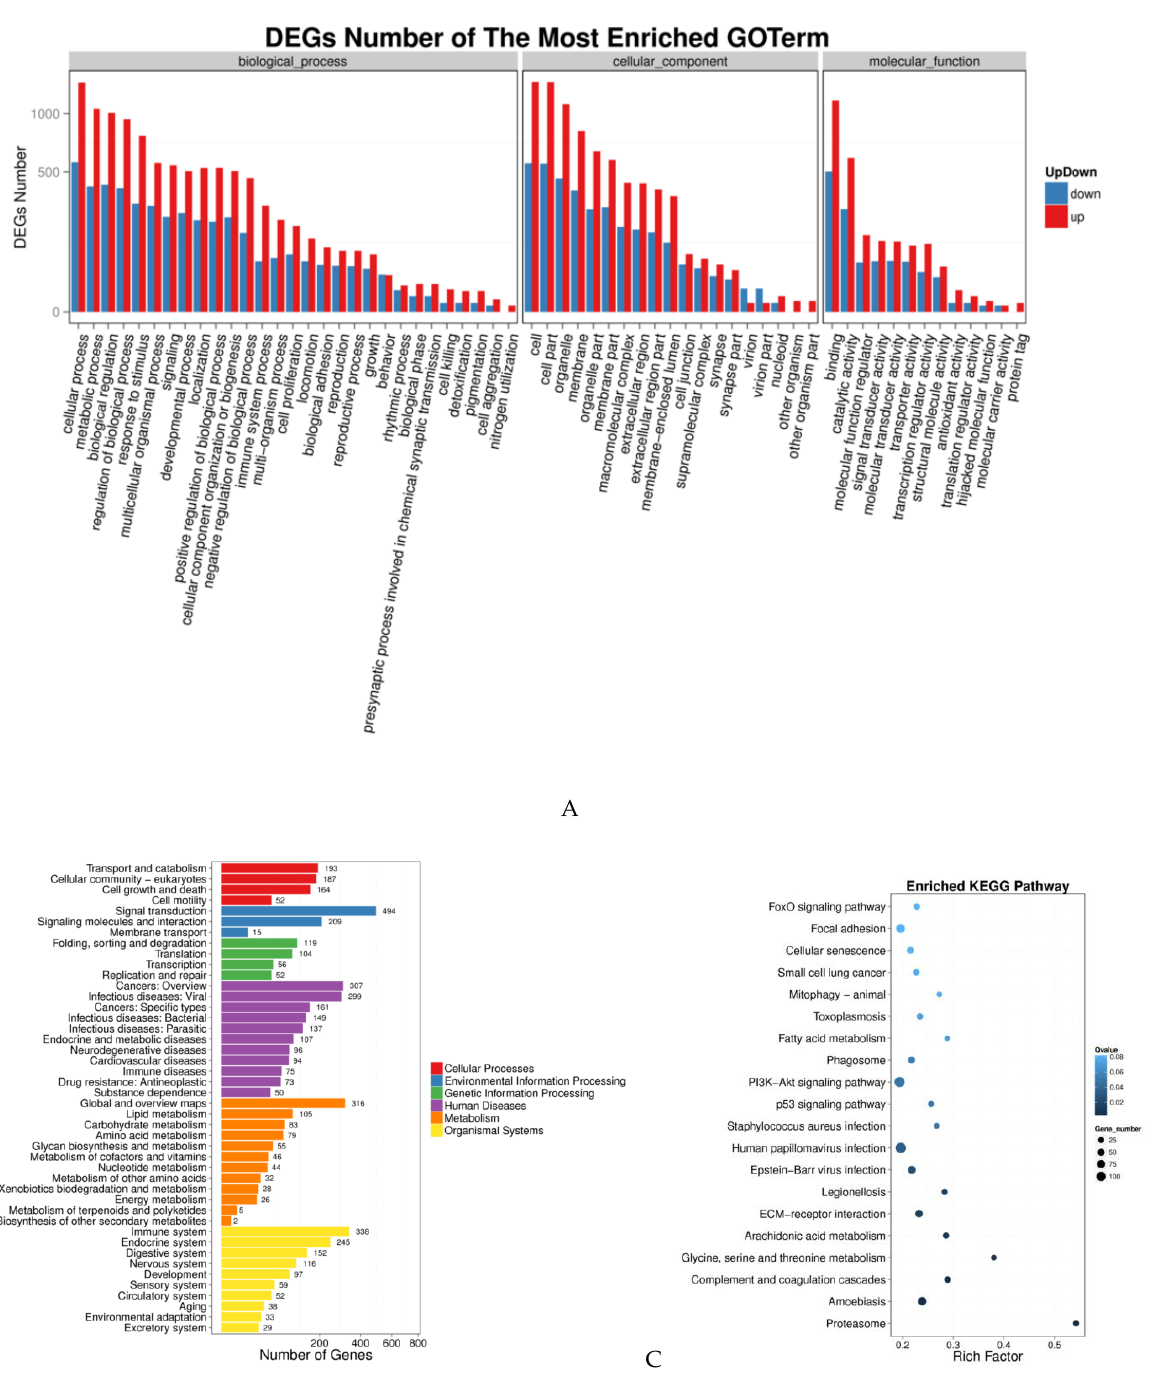
Figure 2. ( A ): Column diagrams for Gene Ontology (GO) analysis of DEGs. The x -axis represents the functions of GO analysis. The y -axis represents the number of DEGs. Red represents upregulated DEGs. Blue represents downregulated DEGs. ( B ): Column diagrams for Kyoto Encyclopedia of Genes and Genomes (KEGG) analysis of DEGs. The x -axis represents the number of DEGs. The y -axis represents the functions of pathways. Each color represents the appropriate biological process. ( C ): Diagrams for the enrichment degree of pathways. The x -axis represents the value of rich factors (the ratio of annotated DEGs to all genes of the enriched pathway). The y -axis represents the names of pathways. The color depth of each point represents the q value. The size of each point represents the number of